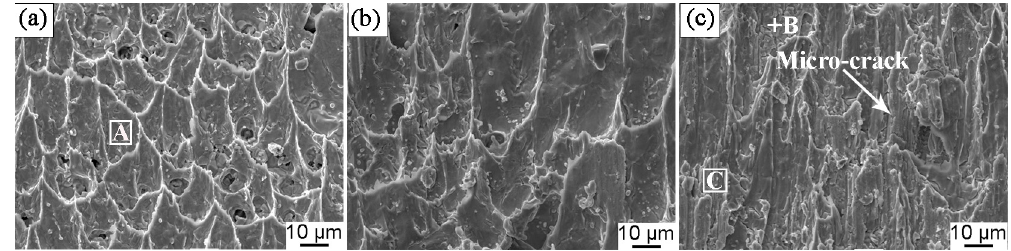
Figure 13. The shear fracture surface of the solder joints aged at 175 ◦ C for a di ff erent time: ( a ) 0 h, ( b ) 192 h, and ( c ) 360 h.